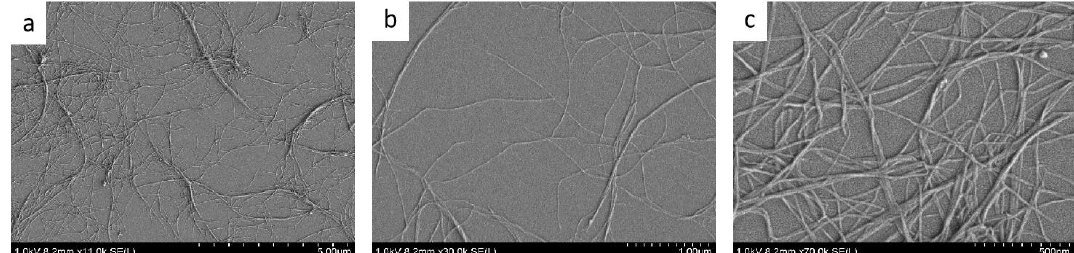
Figure 1. Scanning electron microscope (SEM) images of cellulose nanofibers (CNF) at different magnifications. ( a ) 11 k magnification, ( b ) 30 k magnification and ( c ) 70 k magnification of CNF.